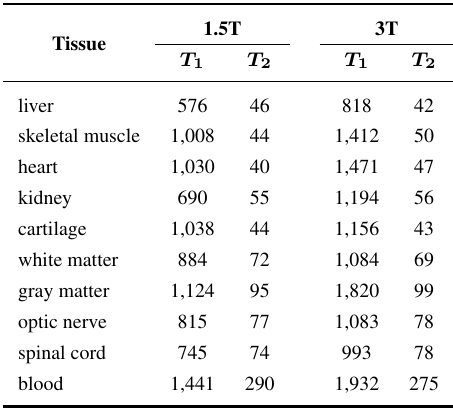
Table 4. Optimal echo times for T case of different minimum T